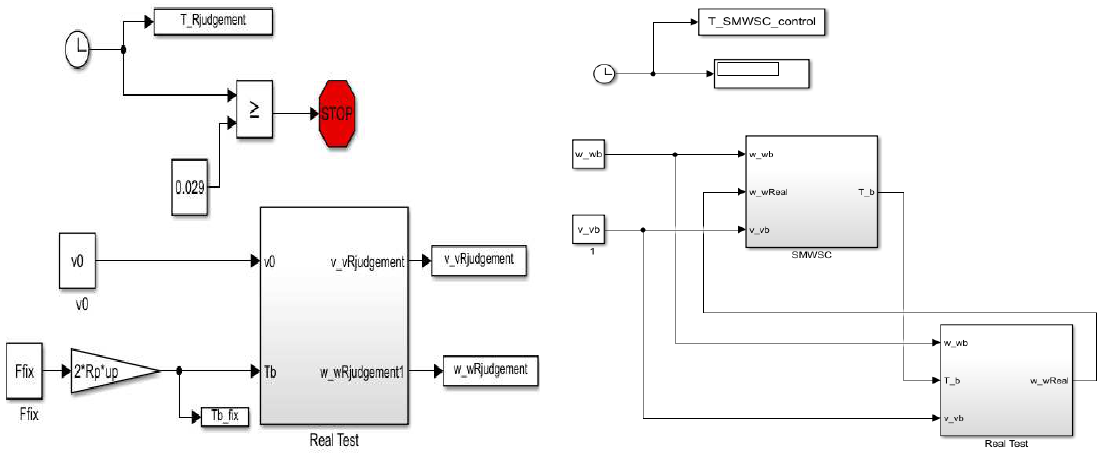
Figure 4. The whole braking process: The road automatic detection period and the ABS control